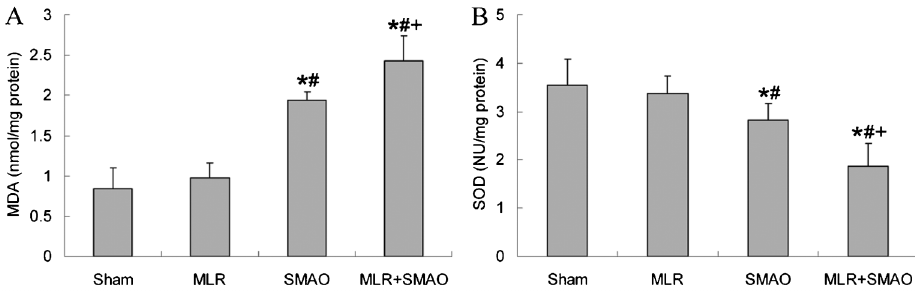
Figure 2. Effect of mesenteric lymph reperfusion (MLR) on the indices related to oxidative stress in splenic homogenate of rats with superior mesenteric artery occlusion (SMAO) shock. Data are reported as means±SD, n=6. A , Malondialdehyde (MDA) level. B , Superoxide dismutase (SOD) activity. *P , 0.05 vs sham group; # P , 0.05 vs MLR group; + P , 0.05 vs SMAO group (one-way ANOVA).